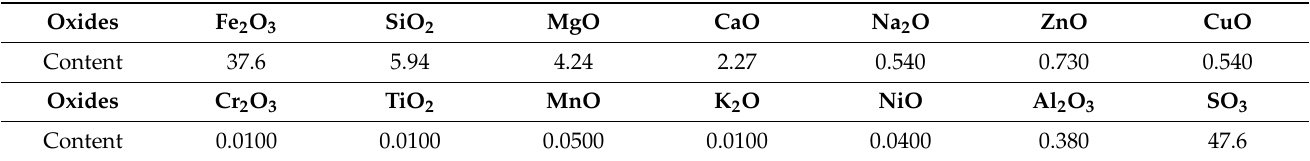
Table 2. XRF Results for sulfide concentrate (wt%).